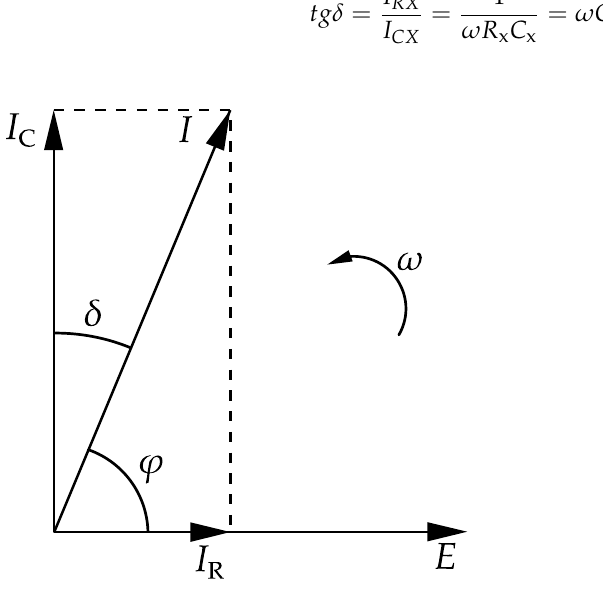
Figure 6. Dielectric loss factor tg δ .